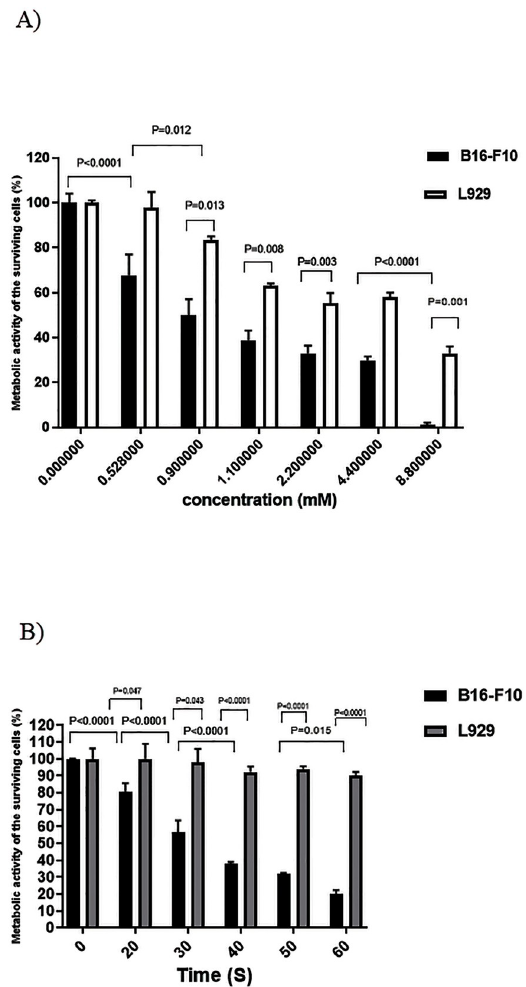
Fig 2. Effect of the nZVI and CAP intervention on the viability of B16-F10 melanoma and L929 normal cells. A) Different concentrations of nZVI and B) different exposure times of CAP.